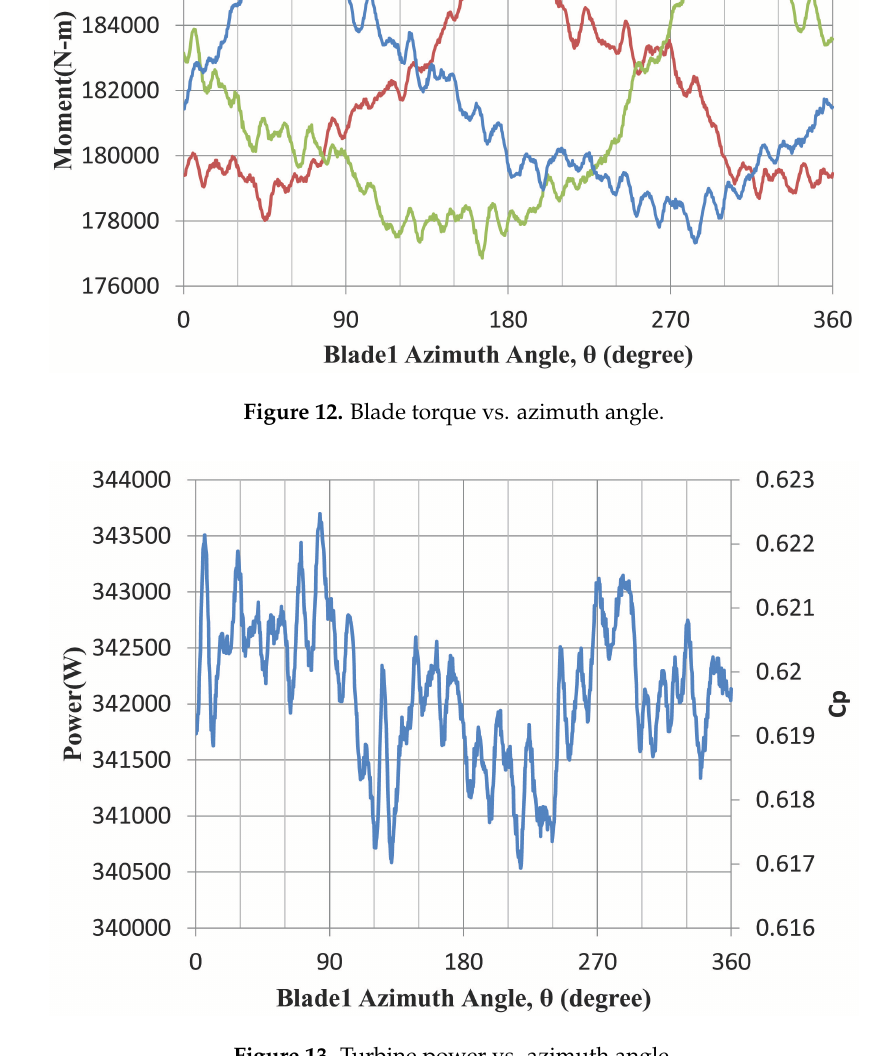
Figure 13. Turbine power vs. azimuth